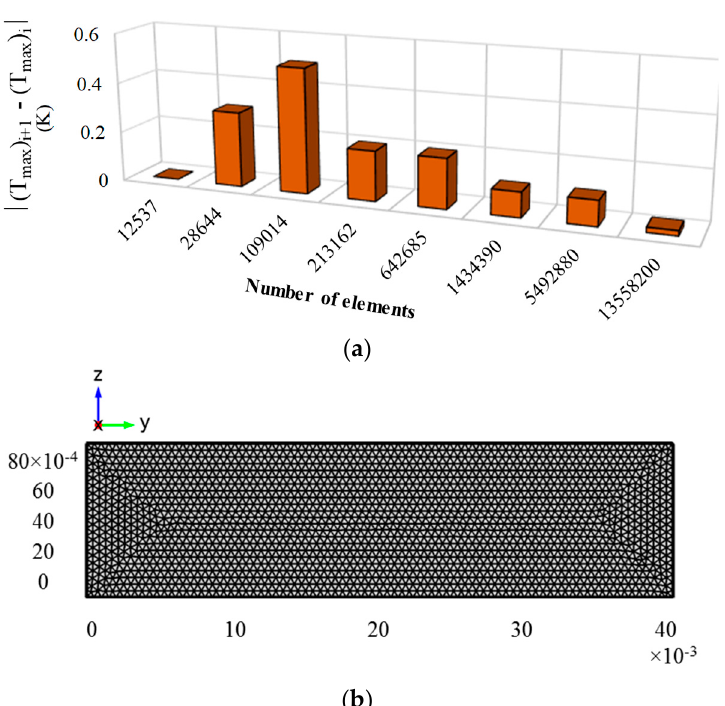
Figure 3. ( a ) Stability of the maximum static temperature of the receiver for different grid systems and ( b ) a generated mesh for the Therminol model. ( b ) a generated mesh for the Therminol